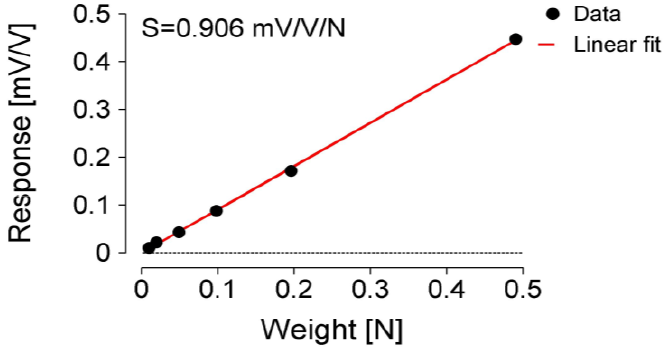
Figure 5. MC sensor